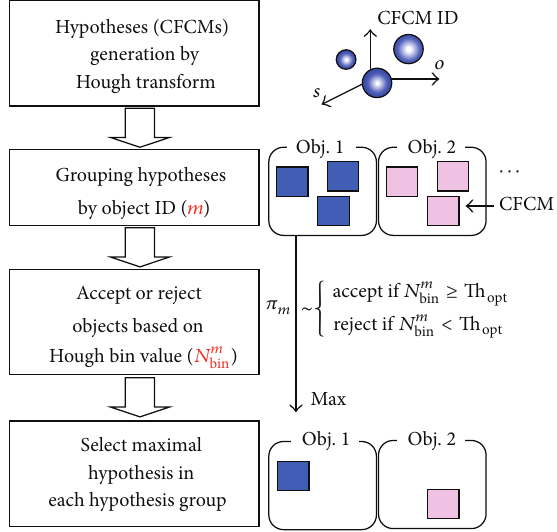
Figure 9: Hypothesis and test (verification) based object recogni- tion